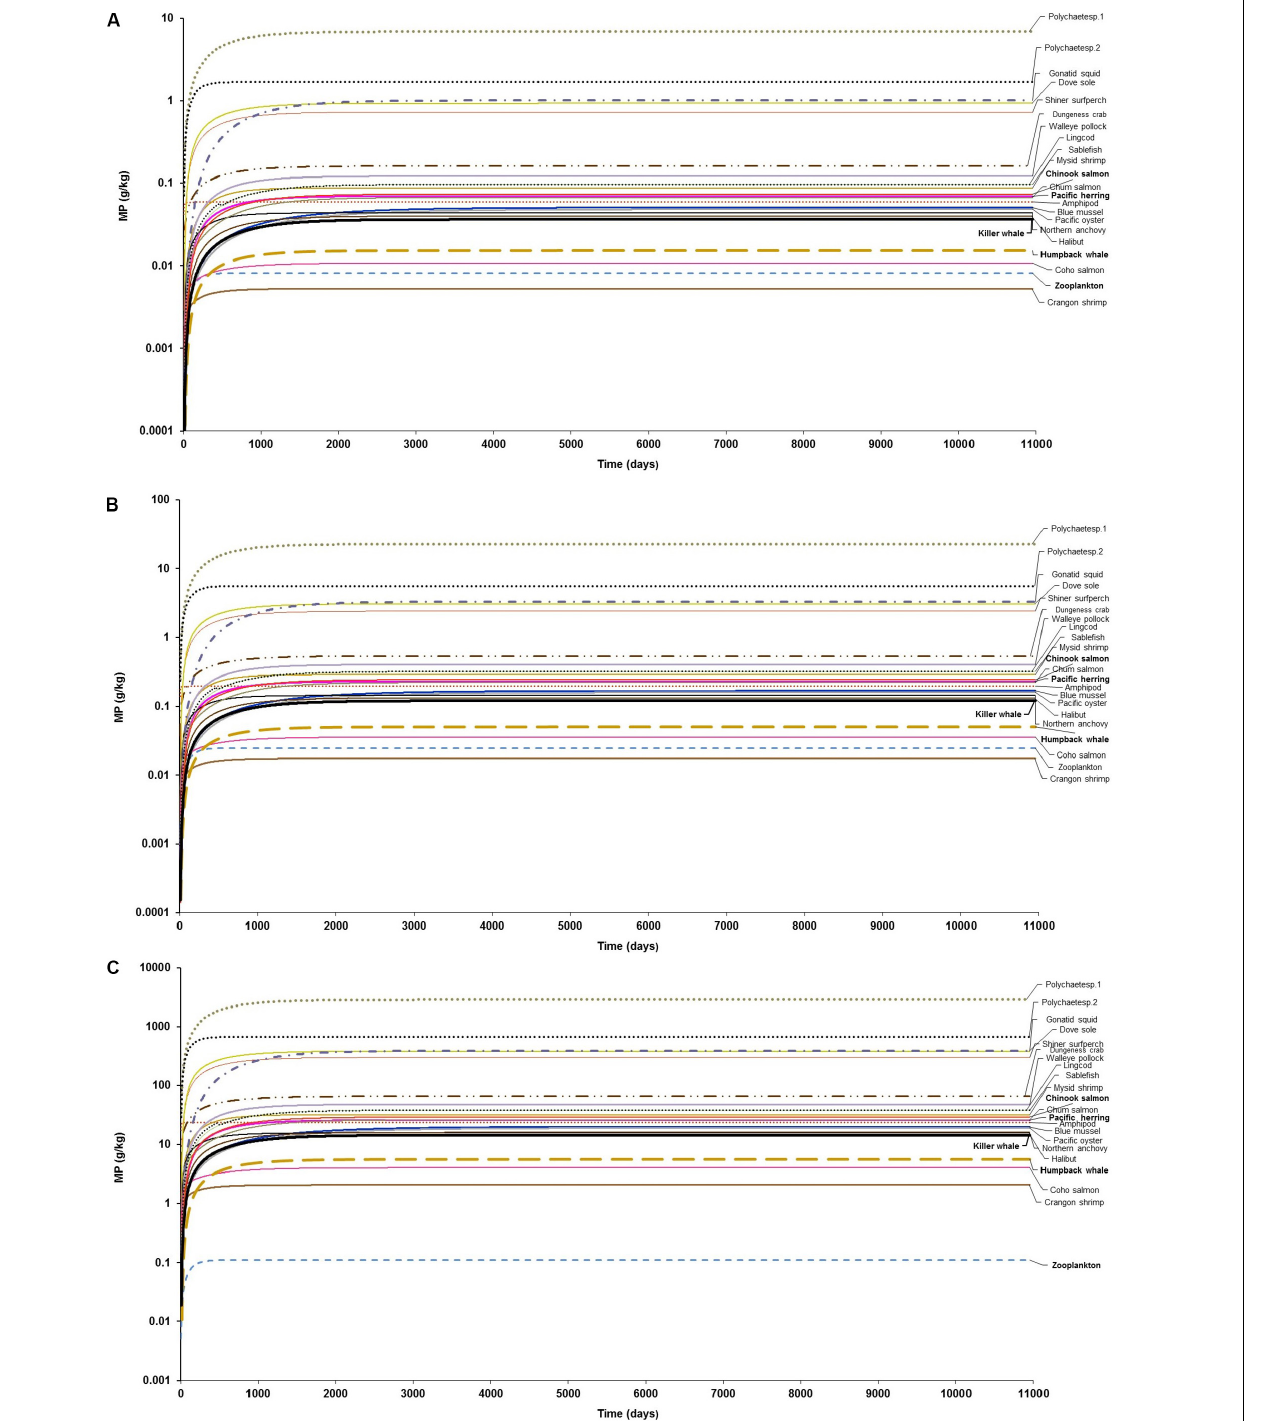
Frontiers in Marine Science |